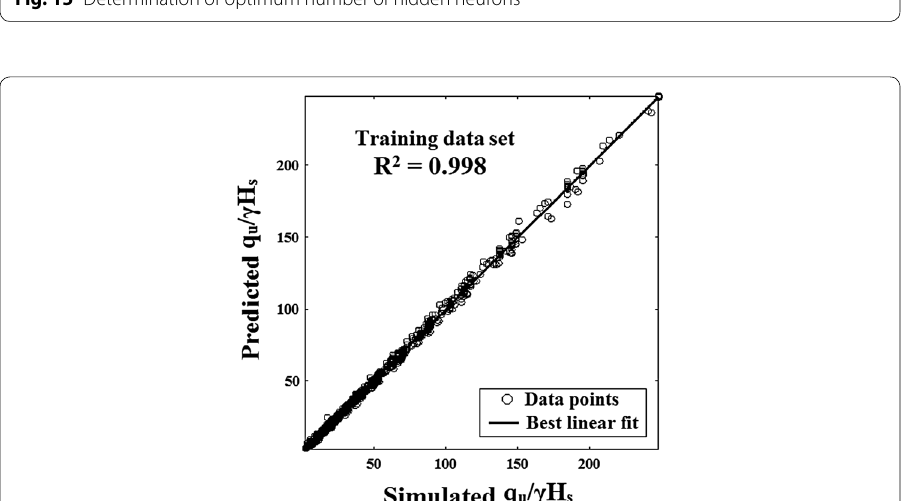
Fig. 15 Determination of optimum number of hidden neurons